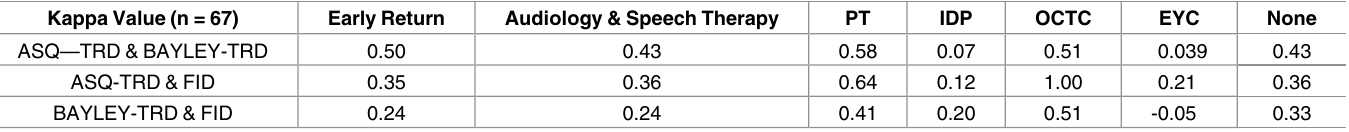
Table 2. Agreement among screening tools for referral to developmental services—kappa coefficients. Kappa Value (n = 67) Early